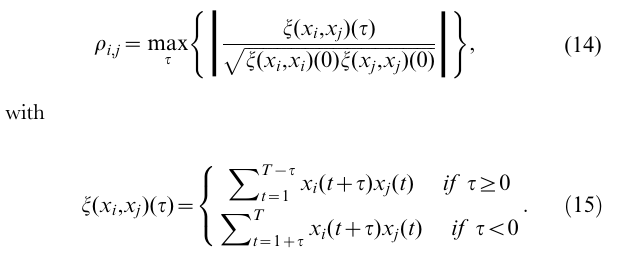
Figure 3. The Kuramoto model with varying coupling strength to demonstrate the ictal (synchronized) and interictal (unsynchronized) behavior of the model. A : For K below a critical value K c (red, dotted line) the signal s ( t ) ~ (1 = N ) P and the order parameter representing the degree of synchronicity is low. If K is above the critical value, s ( t ) is sinusoidal with large amplitude, and the order parameter is large. B : At the onset of synchronization, the oscillators start forming a cluster resulting in an increase of the order parameter. Bars around the circles indicate the phase density of oscillators. The internal frequencies v i are drawn from a normal distribution with mean 0 : 5 and standard deviation 1 . Here we use N ~ 10 4 oscillators.